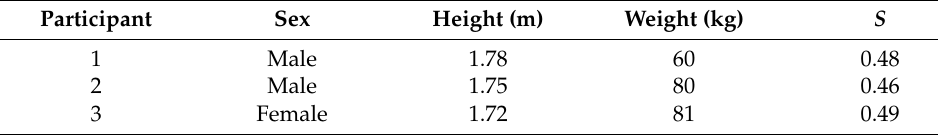
Figure 3. Floor plans of the site for the test. Table 1. Detailed information of all participants ( S is the step length parameter).